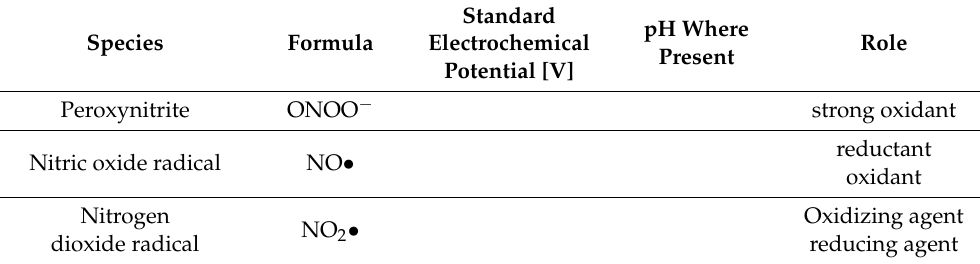
Standard Electrochemical Potential [V] NO 2 •